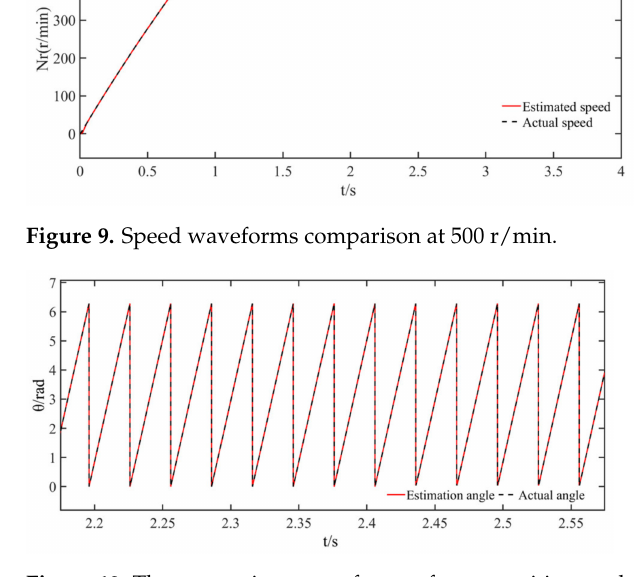
Figure 10. The comparison waveforms of rotor position angle at 500 r/min.